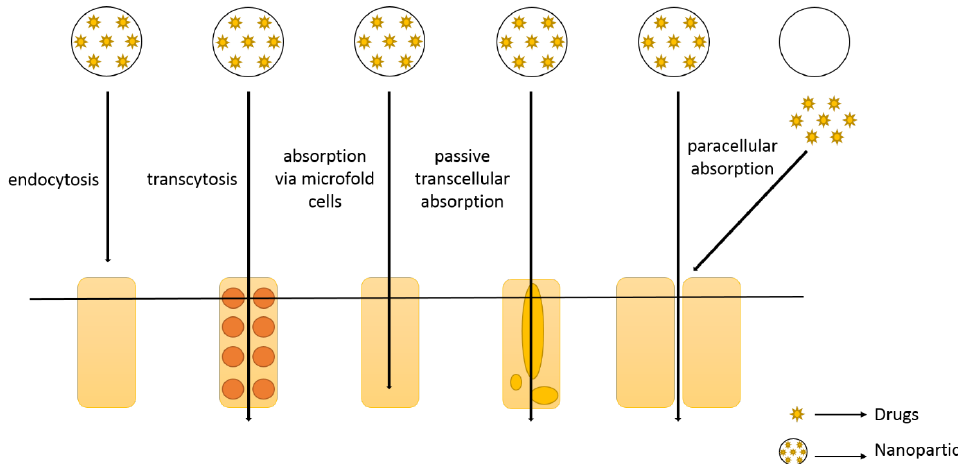
Figure 2. Scheme of various pathways for the oral absorption of nanoparticles through the gastrointestinal tract.